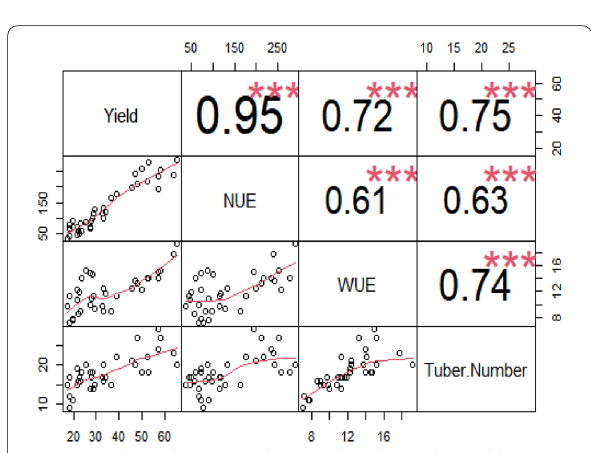
Fig. 9 Correlation between tuber number/plant, tuber yield, WUE and